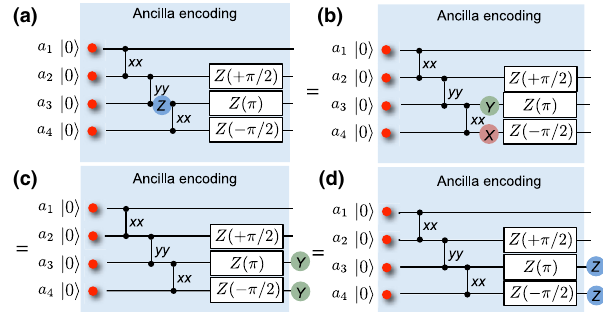
FIG. 11. MS-based circuit for DiVincenzo-Aliferis-type QEC: Initially, a sequence of three two-ion MS gates and local Z rotations is used to prepare the ancilla j GHZ i [see Eq. (28)]. This FIG. 12. Dangerous error propagation during the encoding state is subsequently coupled transversally by four X -type MS gates to the data qubits, thereby mapping the S stabilizer x eigenvalue information onto the relative phase of the GHZ state. The decoding circuit, formed by local Z rotations and two two-ion MS gates, is constructed in such a way that a harmful two-qubit error, which has propagated to the code layer, is unambiguously signaled by the M z 3 ¼ þ 1 ; M z 4 ¼ − 1 measure-